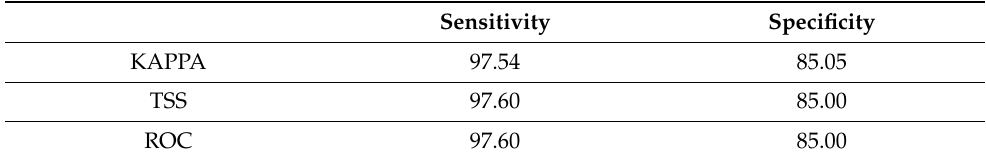
Table 3. Results of the topographic niche model. Measures of sensitivity and specificity (Kappa, TSS,